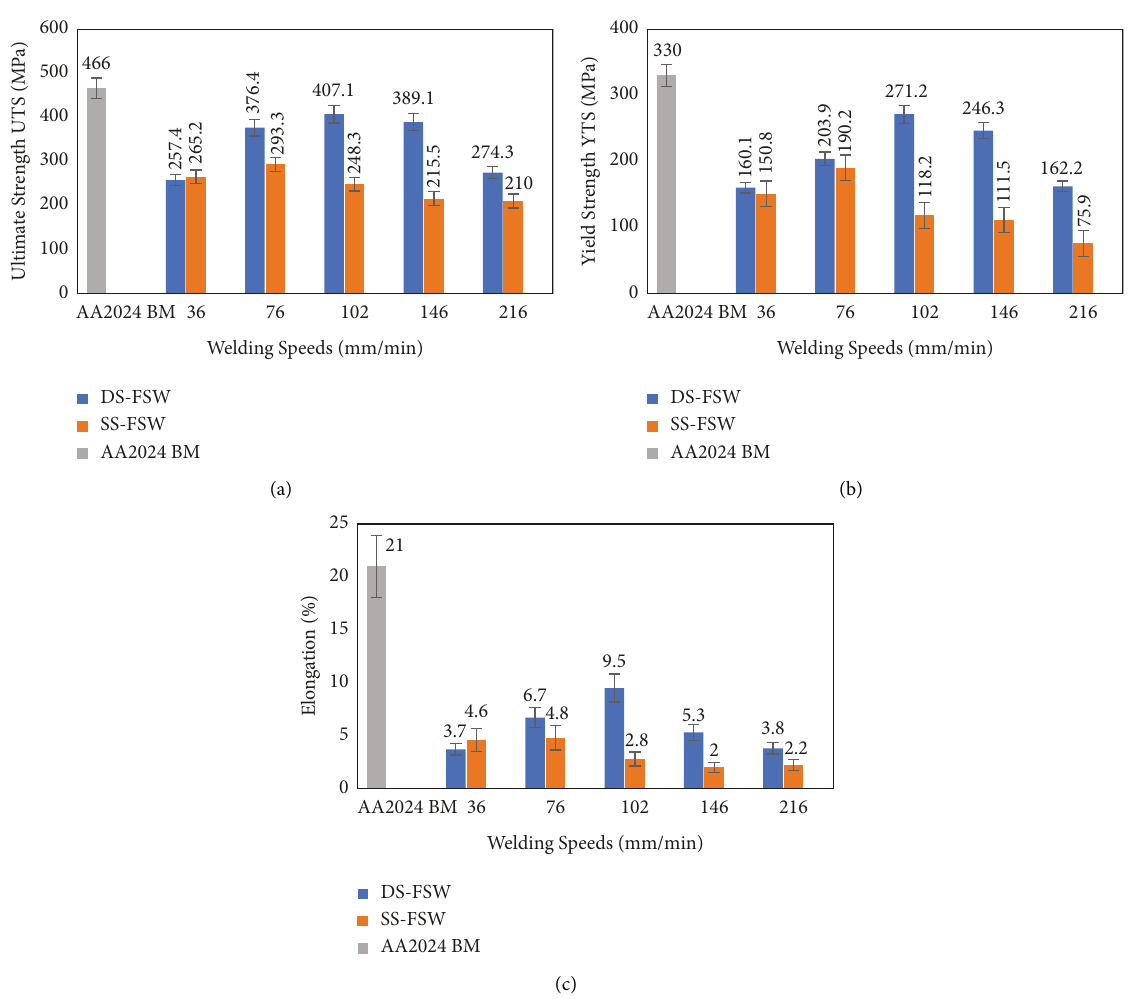
Figure 2: Tensile properties of the DS-FSW and SS-FSW hybrid joints in various welding speeds. (a) UTS, (b) YTS, and (c)